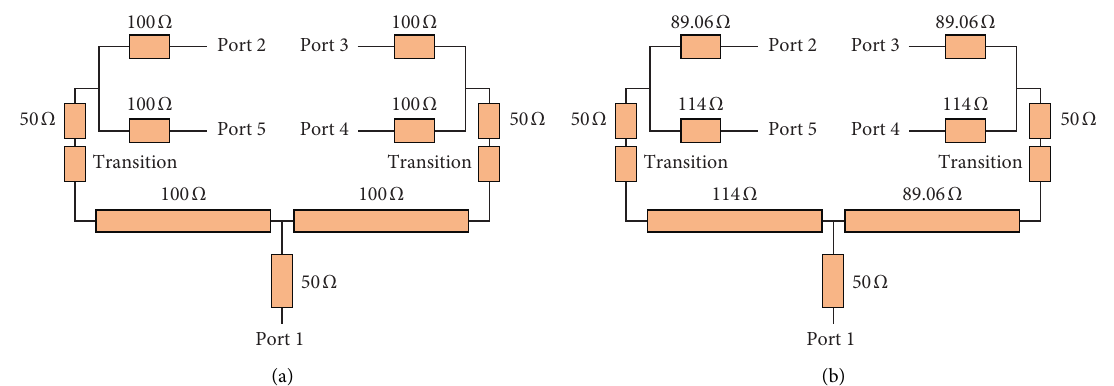
Figure 6: Schematic of four-way feeding network: (a) FC power divider; (b) UA power